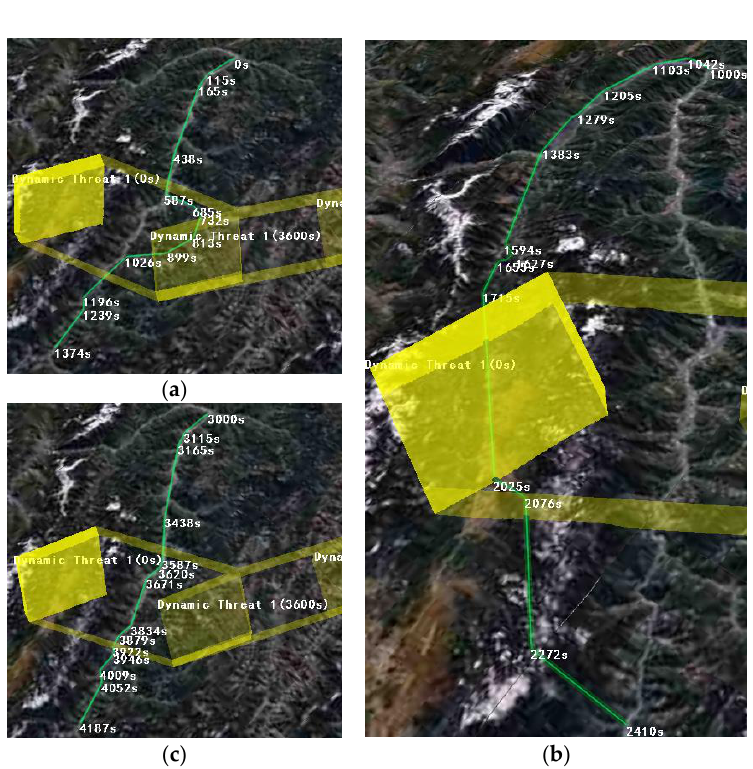
Figure 26. The results of different start times under dynamic threats. ( a ) Start time = 0 s; ( b ) Start time = 1000 s; ( c ) Start time = 3000 s.